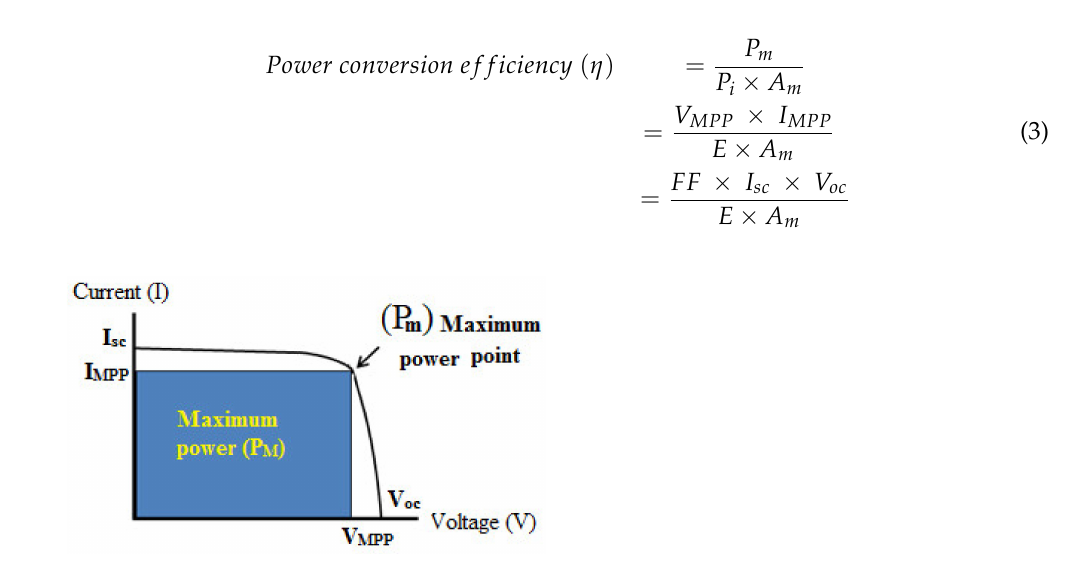
Figure 2. The I-V curve for PV solar system.